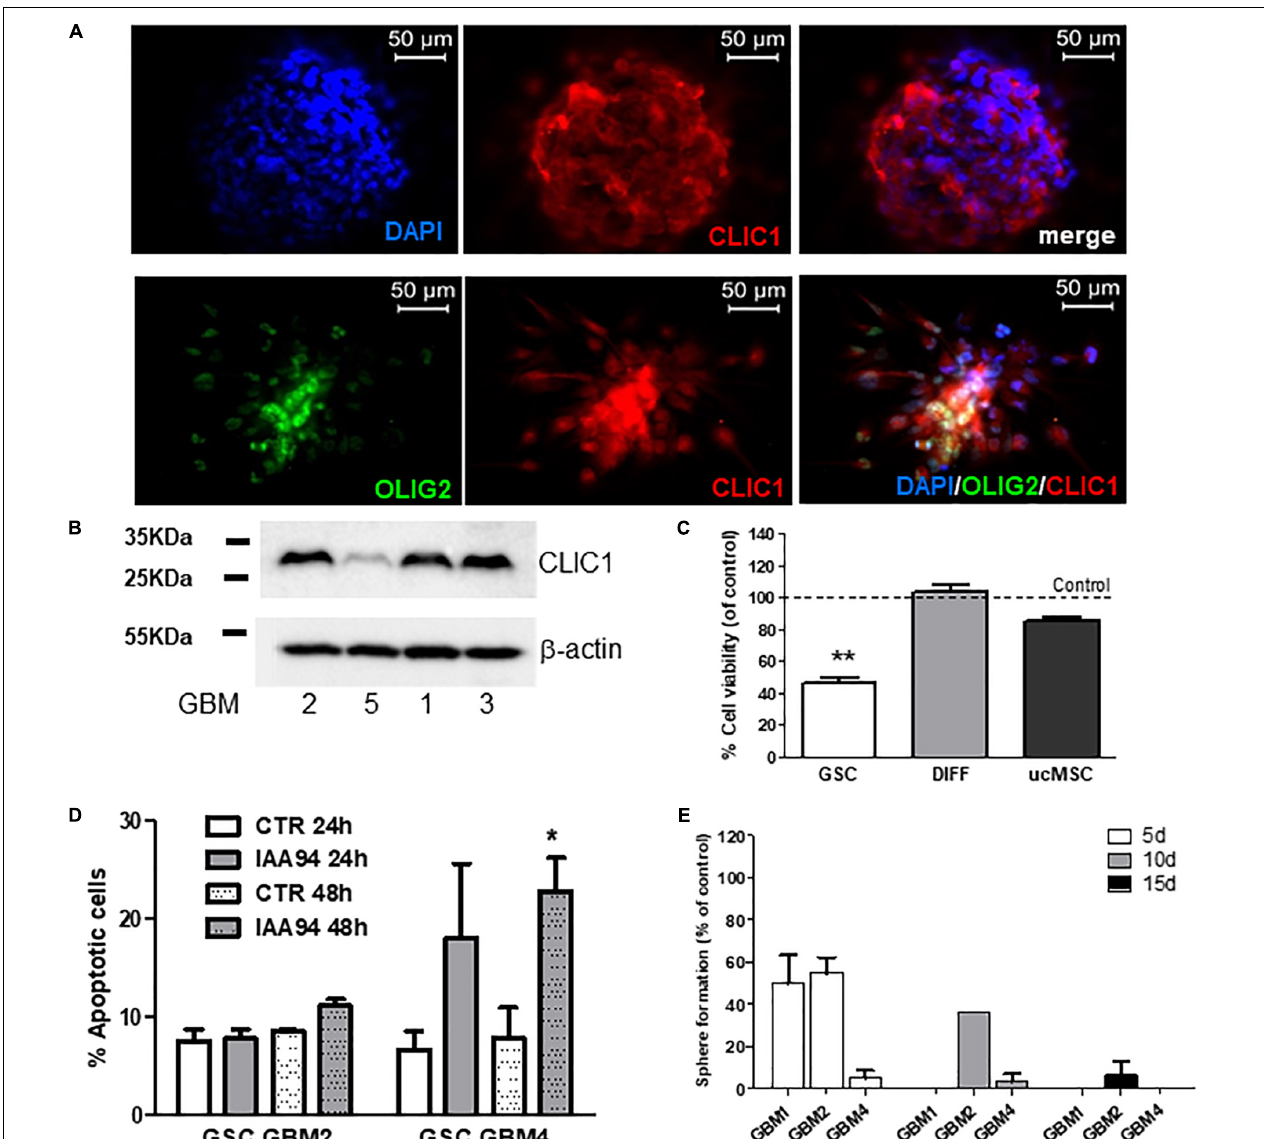
FIGURE 7 | CLIC1 expression in glioblastoma spheroids and its role in cell viability, apoptosis, and self-renewal of glioblastoma stem cells. (A) CLIC1 expression was analyzed in GBM4 (upper) and GBM6 (lower) spheroids by immunofluorescence experiments. High expression of CLIC1 was detected in both spheroids, also showing a high level of co-localization with the stem cell marker OLIG2 (lower). (B) Representative Western blots showing the expression of CLIC1 in GSC cultures derived from GBM1, 2, 3, and 5. Beta-actin was used as reference housekeeping gene. (C) Effect of the CLIC1 inhibitor IAA94 (100 µ M) on the viability of GSCs and their differentiated (DIFF) counterpart, and umbilical cord mesenchymal stem cells (ucMSC), measured by MTT assay. Only in GSCs, CLIC1 inhibition caused reduction of cell viability. Data are the mean of n = 2 experiments performed in quadruplicate, on each culture derived from 5 GSC cultures (GBM2, 3, 4, 5, 6), 3 differentiated cultures (GBM2, 3, and 4), and 3 independent ucMSC cultures. Dotted line represents control level set at 100%. ∗∗ p < 0.01 vs. CTR cells. (D) Effect of IAA94 (100 µ M) on the induction of apoptosis in GSCs from GBM2 and GBM4, measured by annexin V binding. A moderate pro-apoptotic effect (about 23% annexin V-positive cells) was observed only after 48 h of treatment in selected cultures (i.e., GBM4), while other cultures (GBM2) were not affected. Data are expressed as the mean of n = 3 independent experiments. ∗ p < 0.05 vs. CTR ( t -test). (E) Effect of IAA94 (100 µ M) on GBM1, 2, and 4 spherogenesis. Cells were treated for 5 days with vehicle and IAA94 and the number of spheres counted and then disaggregated. 1000 cells were the replated and allowed to generate spheres for other 5 days (10 days) after then counted again, disaggregated and 1000 cells replated to form tertiary spheres for further 5 days (15